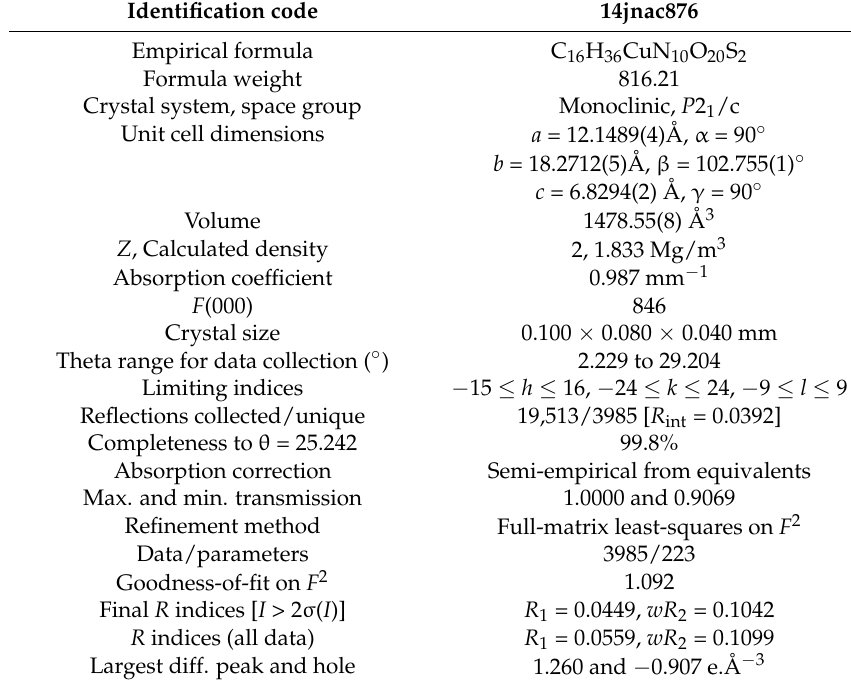
Table A1. Crystal data, structure solution, and refinement of compound 1 .